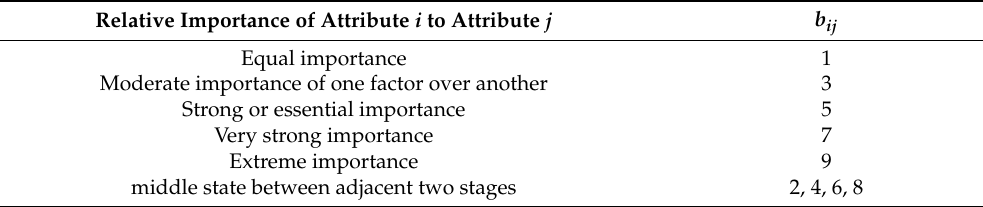
Table 1. Linguistic Scales of